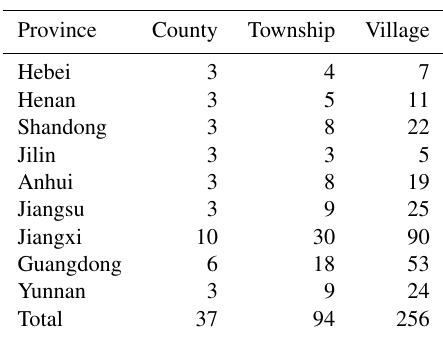
Table A1. Sample distribution of this study.